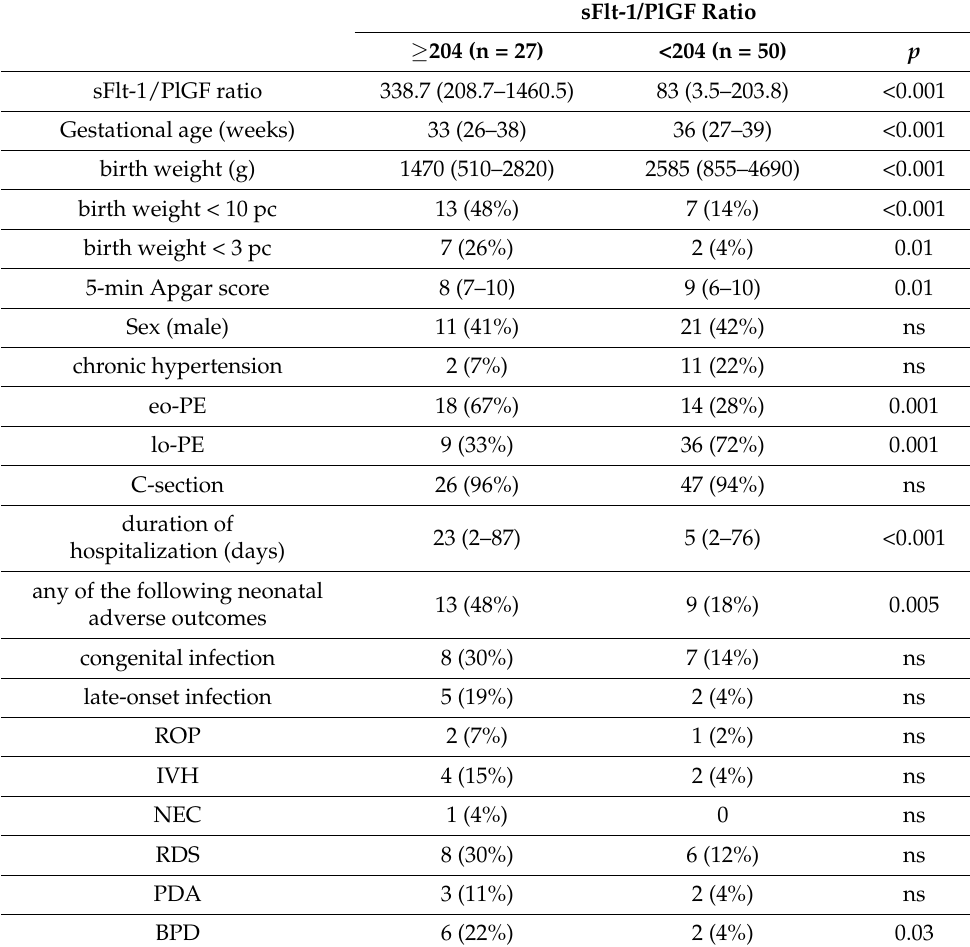
Table 2. Perinatal outcomes and neonatal complications depending on the sFlt-1/PlGF